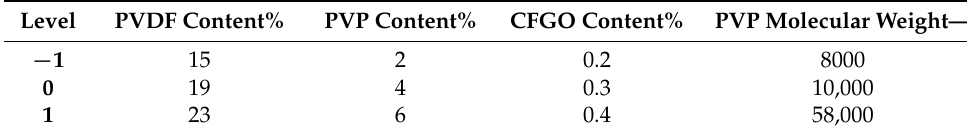
Table 1. Influencing factors and levels of experimental design.